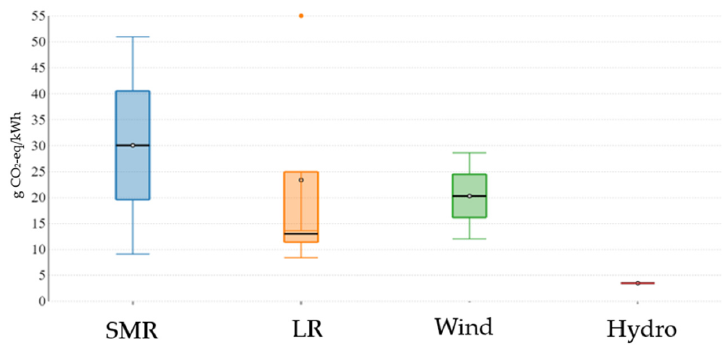
Figure 9. LCA Results according to various